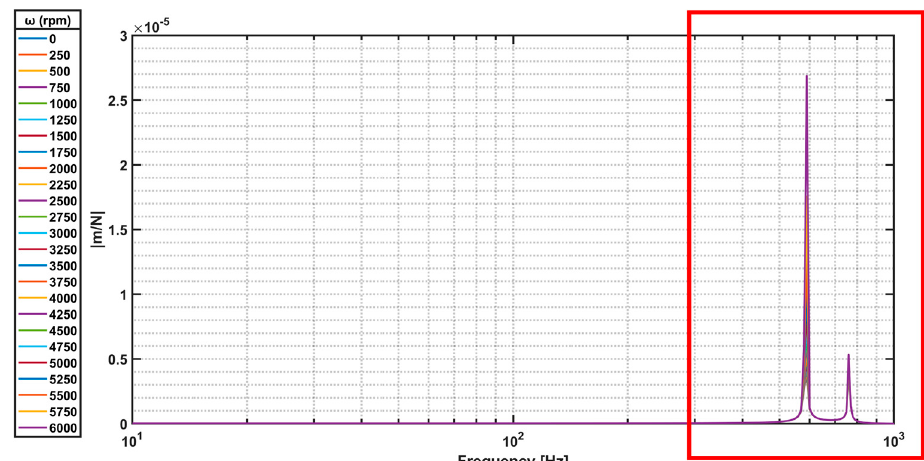
Figure 12. Transfer function plotted at different ω .